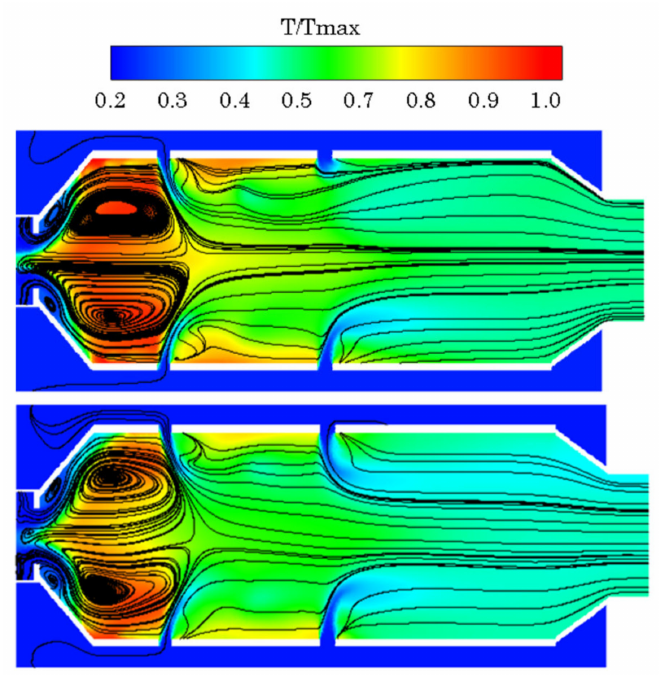
Figure 19. Temperature field with flow streamlines for natural gas ( top ) and biogas ( bottom